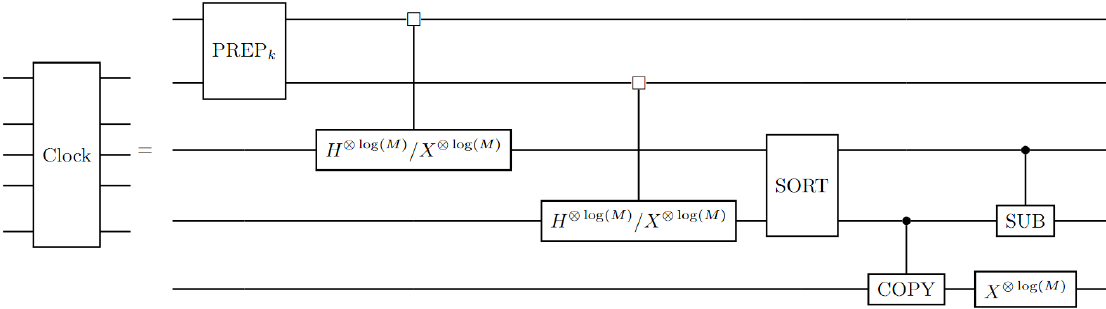
can be computed with 2